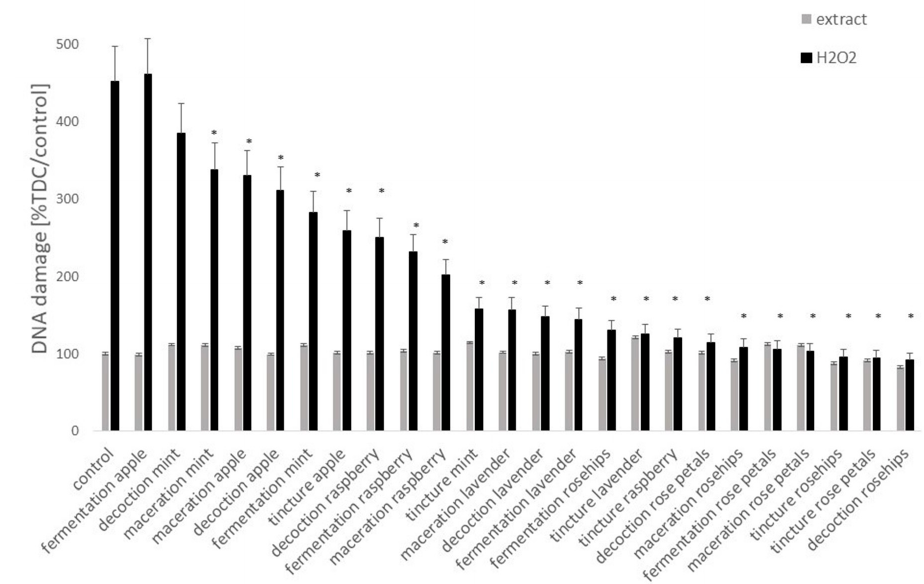
Figure 3. The DNA damage in lymphocytes measured using the comet assay after exposure to the analyzed extracts for 1 h. Oxidative DNA damage was induced by incubation of cells in 25 µ M H 2 O 2 . * Asterisks indicate the significant di ff erence between the results obtained for cell treated with plant extracts and H 2 O 2 in comparison to cells treated with H 2 O 2 only. The results of the comet assay are expressed as tail DNA content (TDC) and are presented as % of damages in control sample (untreated